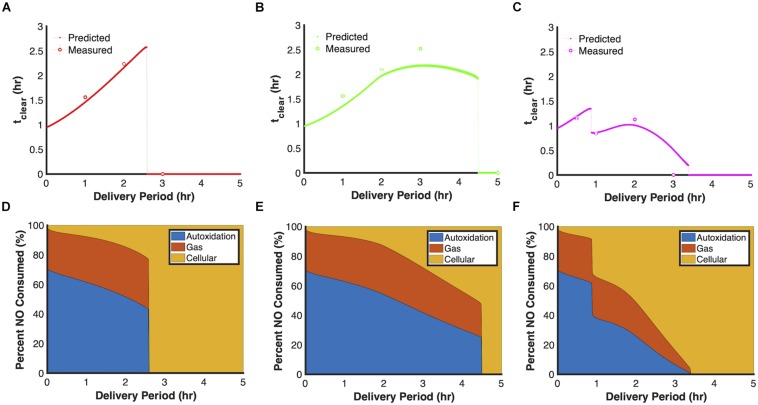
Relationship between tclear and delivery period. Model simulations using the ensemble of parameter sets (ER < 10, 28 sets in total) were performed by delivering 24 μmol PAPA NONOate and varying the delivery period between 0 and 5 h and calculating tclear for each simulation. (A) Constant, (B) ramp down, (C) ramp up. Solid lines represent predicted relationship between tclear and delivery period, while dashed lines represent discontinuities in the curves. Circles represent mean tclear values from at least three experiments and error bars represent the standard error of the mean. Predicted NO cumulative distribution profiles using the optimal parameter set (ER = 1, minimum SSR, 1 set) up to the end of the delivery period or when [NO] dropped below 0.5 μM, whichever was greater for constant (D), ramp-down (E), and ramp-up (F) delivery schedules. The three major NO consumption pathways are autoxidation (blue), transport to gas phase (red), and cellular consumption (yellow).